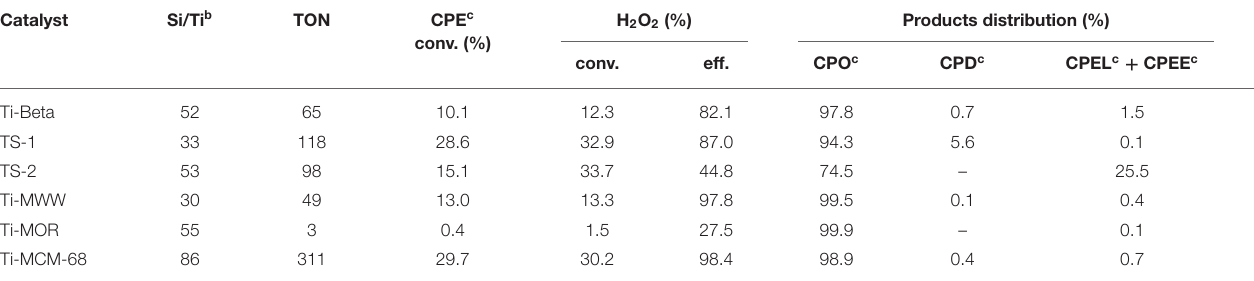
TABLE 1 | A comparison of the catalytic performance of various titanosilicates in the cyclopentene epoxidation reaction with MeCN as the solvent a . Catalyst Si/Ti b TON CPE c H 2 O 2 (%) Products distribution (%) conv. (%) conv. eff. CPO c